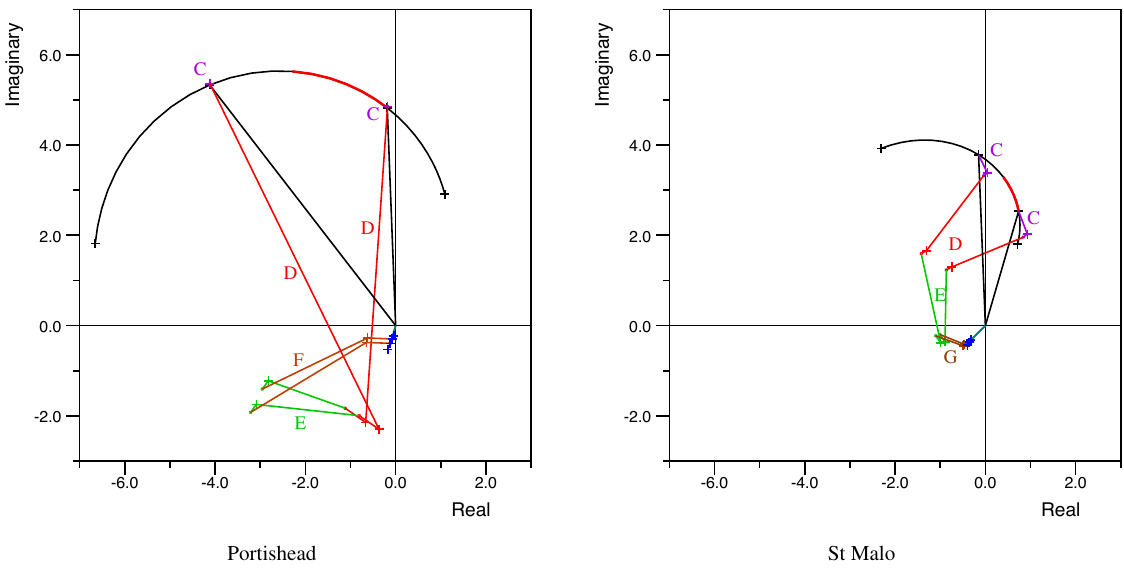
Fig. 10. Polar plot of the Portishead and St. Malo response functions (black) between 11 and 14 radians per day. Crosses are at intervals of one radian per day. The figure also shows the contributions at 12 and 13 rad/day of resonances C (purple), D (red), E (green), F (brown) and G (dark brown) of table 3, their much smaller conjugates (same colours) and the residual (blue). If this is also true for the resonances reported here, it would double their distance from the real